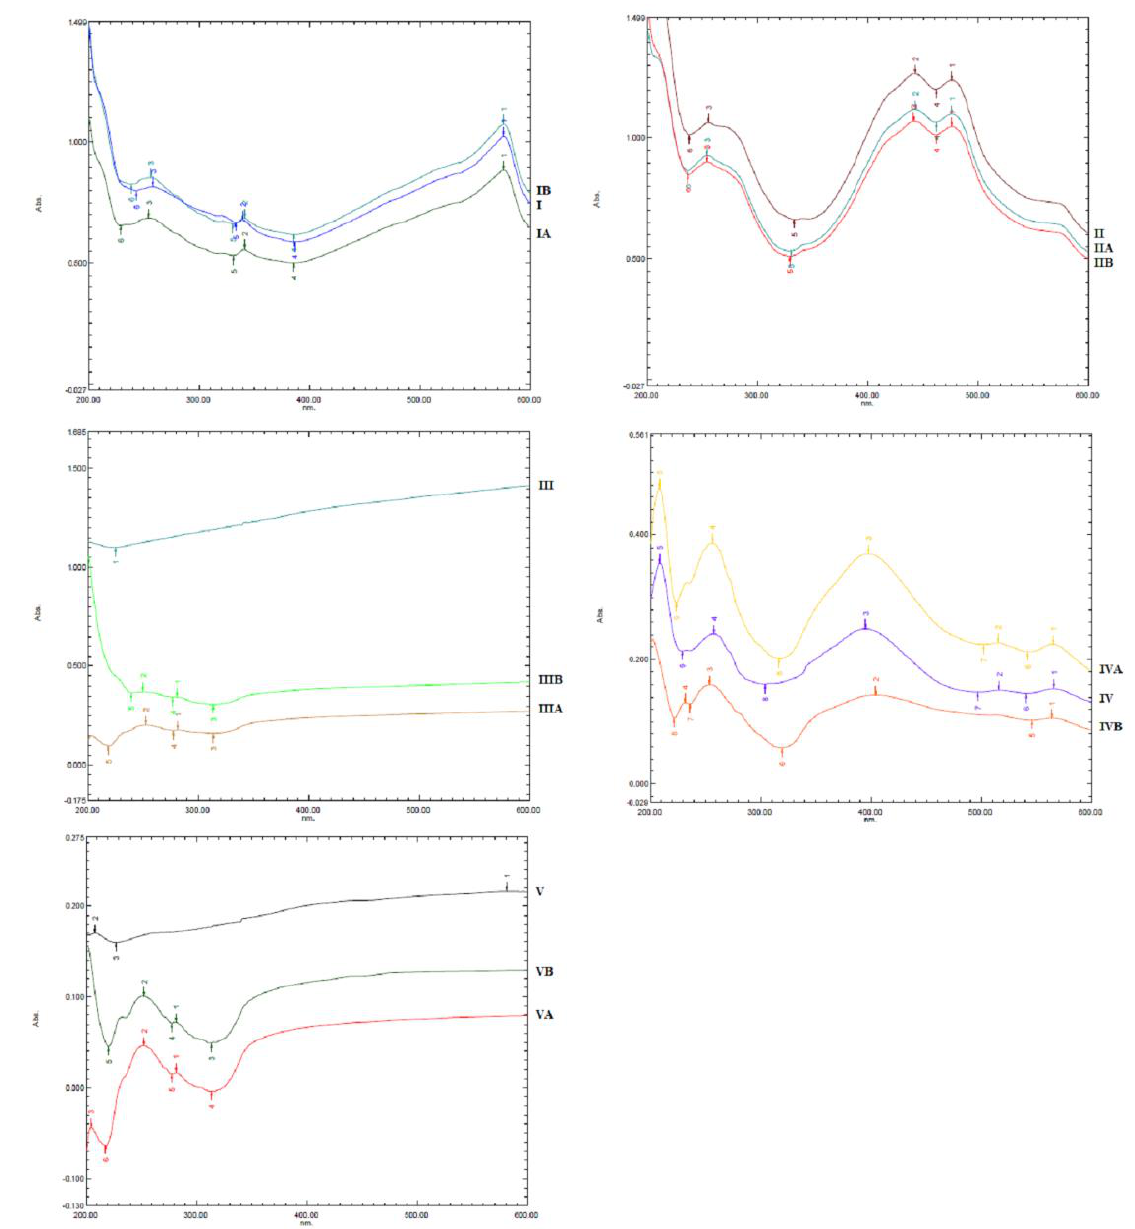
Figure 1. Absorption spectra of the aqueous solution of each ink (1–5) after mixing them with PE (A) or PPO (B) and incubation at 37 °C for 60 min.